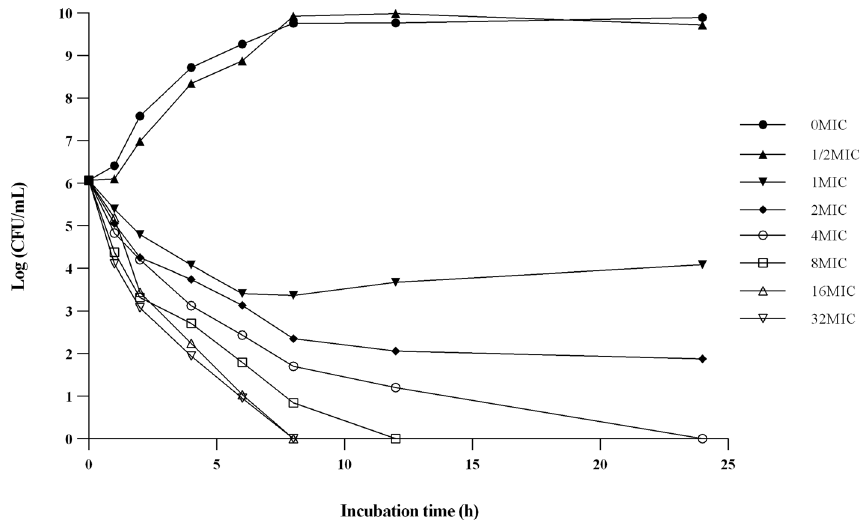
Figure 3. The in vitro time killing curve of DAN against E. coli HP501 (O 158 , MIC = 0.5 μg/mL).